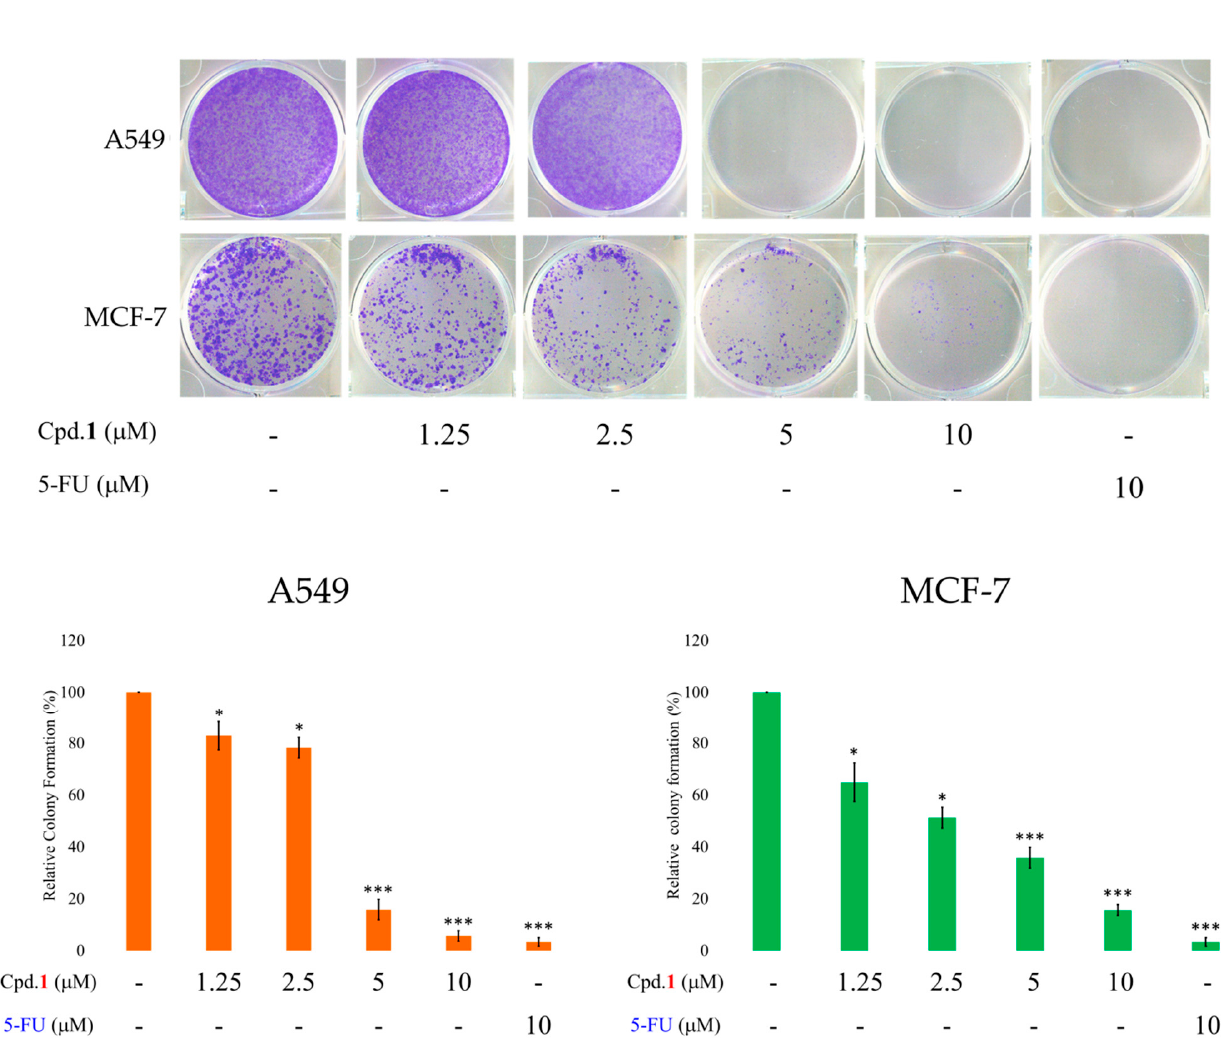
Figure 7. Compound 1 inhibited the growth of human non-small-cell lung cancer cell (A549) and human breast cancer cell (MCF-7) in a dose-dependent manner (1.25–10 µ M) by the colony-formation assay. The data were expressed as mean ± SEM ( n = 3). Asterisks indicate significant differences (* p < 0.05 and *** p < 0.001) compared with the control group.